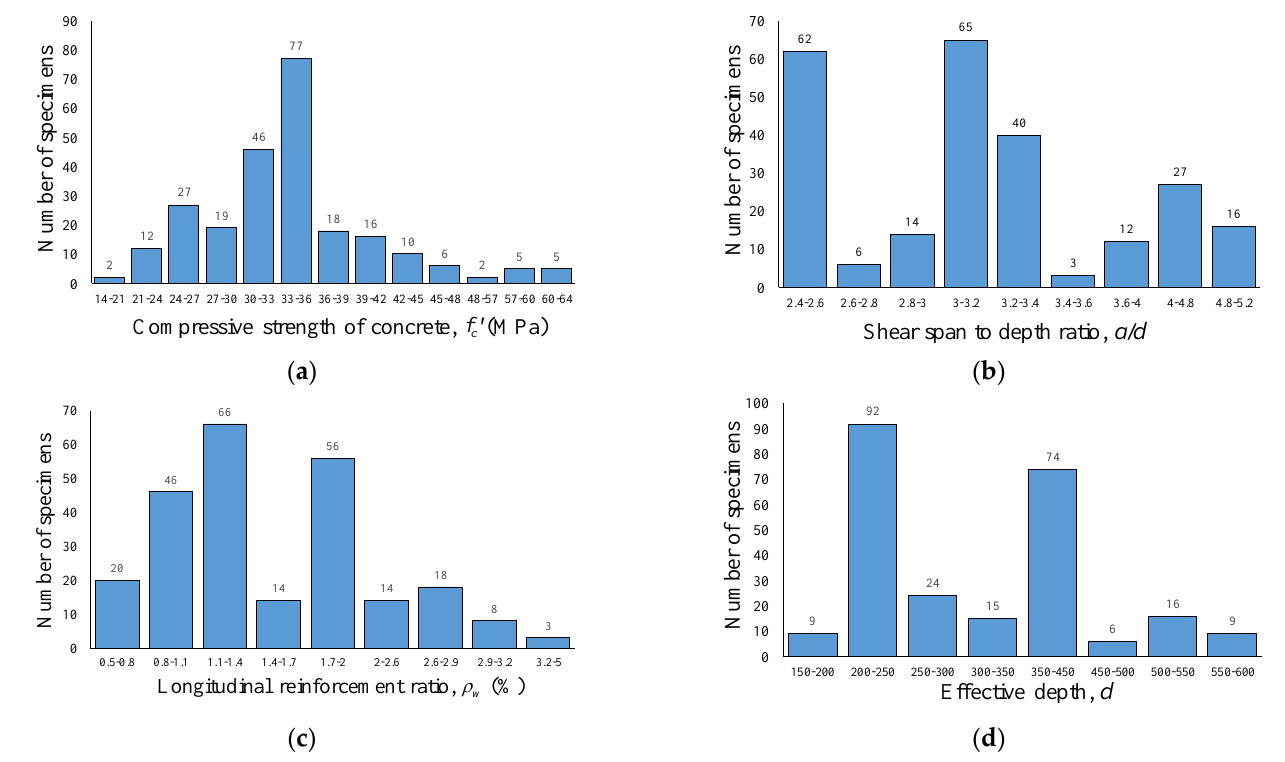
Figure 3. Distribution of key parameters in RCA without shear reinforcement. ( a ) Compressive strength of concrete, MPa. ( b ) Shear span-to-depth ratio. ( c ) Longitudinal reinforcement ratio. ( d ) Effective depth.